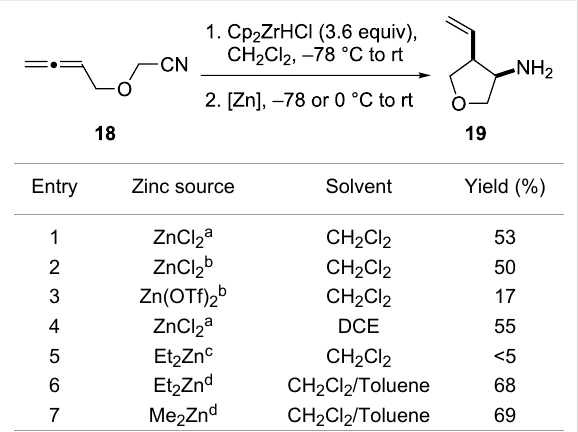
Table 3: Optimization of the intramolecular reductive coupling of allene and nitrile to give tetrahydrofuran 19 .